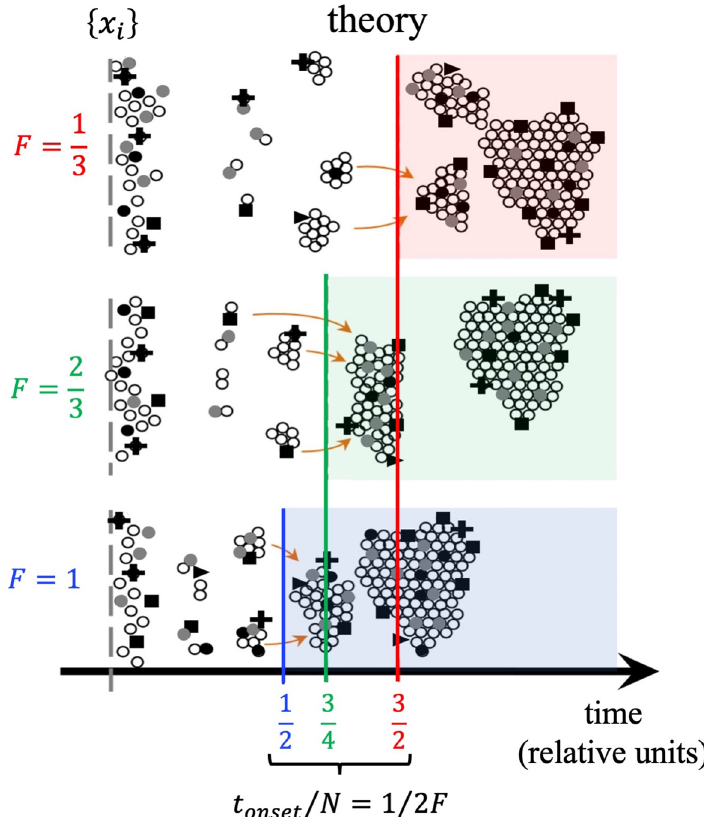
Figure 3. Collective chemistry. Sudden appearance of a large clump of correlated objects, which is referred to in the physical and chemical literature as a gel, or in the network science field as the giant connected component (GCC). This is shown for different values of the average aggregation probability F . F depends on −→ x i values) and the grouping mechanism (see the initial composition of the population (i.e. distribution of SI Sect. 2.2, Eqs. (1), (2)) and hence embodies the collective chemistry. For a uniform initial composition, an F value of 1 indicates any individual could fit into any group, 2/3 indicates grouping via homophily, and 1/3 indicates grouping via heterophily. The horizontal axis time values are scaled so that t onset = N / 2 F appears as t onset / N = 1 / 2 F , e.g. onset time for F = 2 / 3 appears as 1 / 2 F = 3 / 4 . The accompanying mathematical theory is described in full detail in Sect. 2 of the